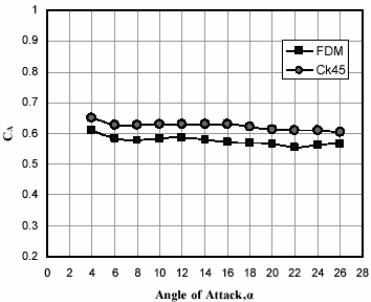
Fig.7 Comparison of pitching moment coefficient at Mach 0.9